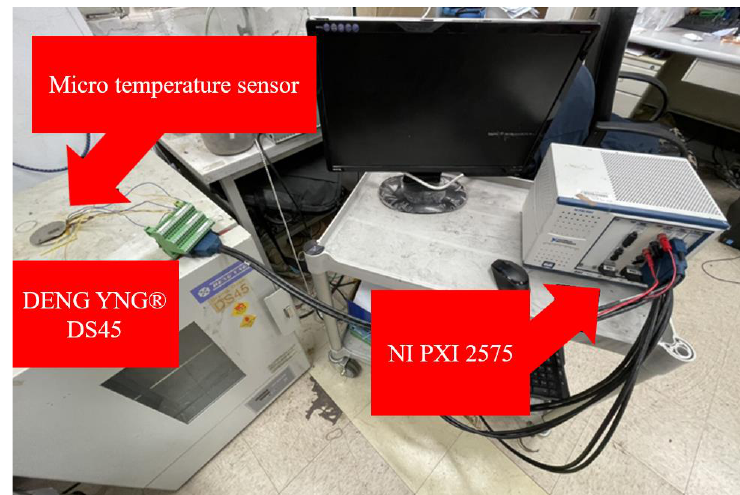
Figure 3. Temperature correction test.